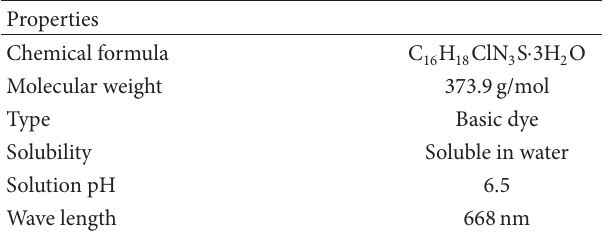
T 3: Some properties of the MB